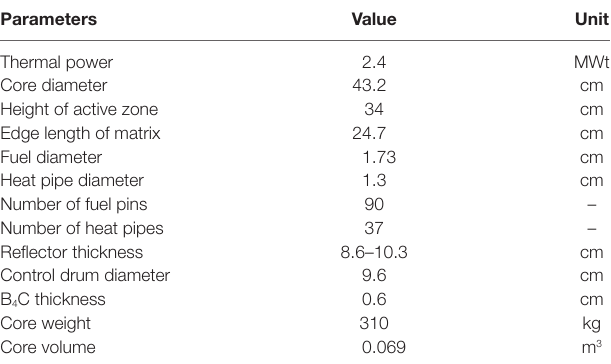
Table 1 | Core design parameters.